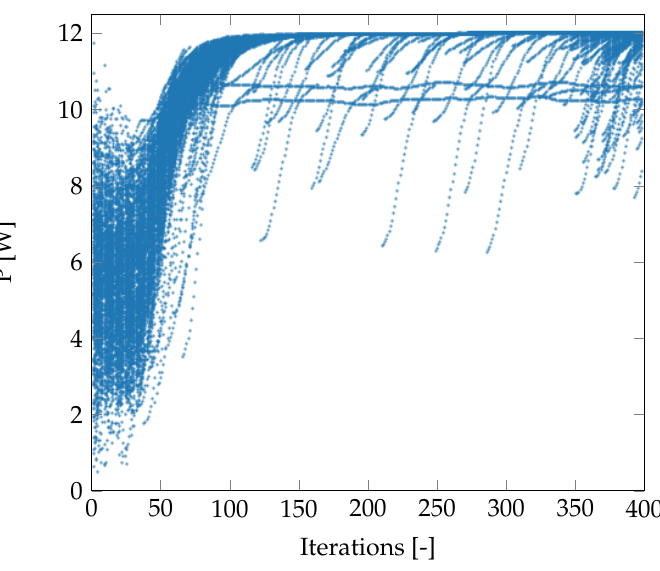
Figure 22. Solutions of individual particles per time step.